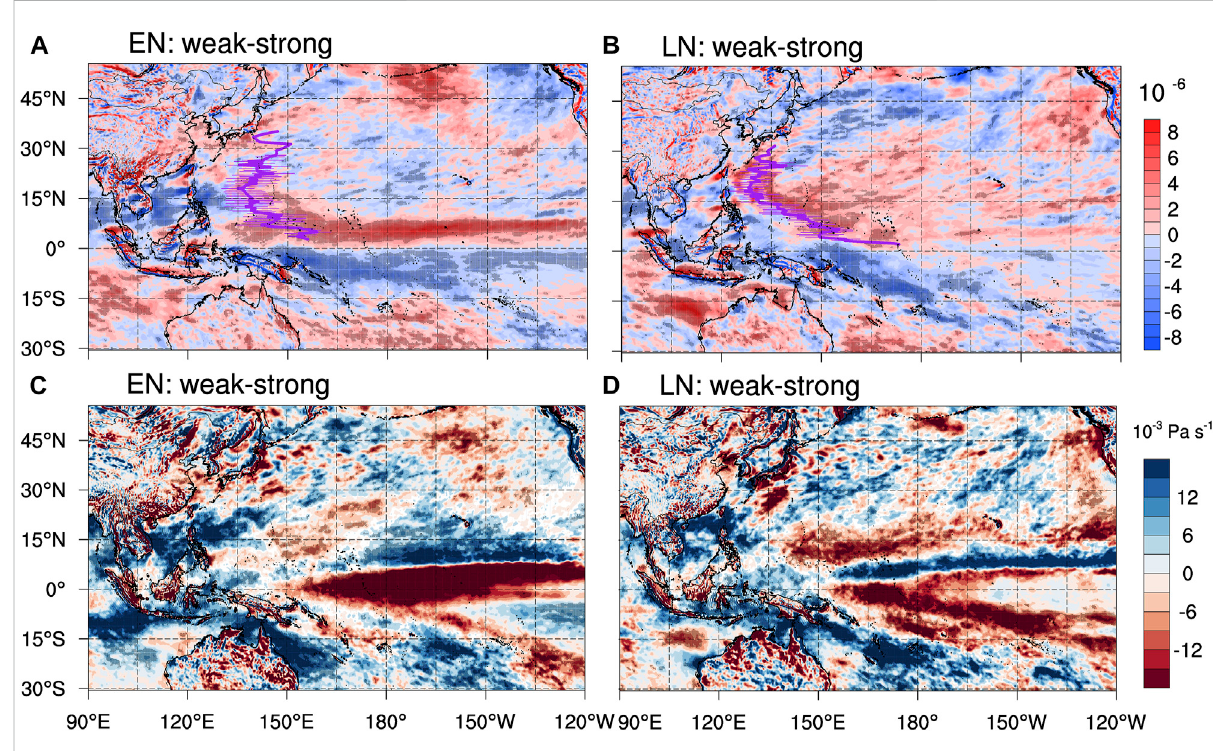
Circulation distributions, averaged during October ‒ December, at the height of 850 hPa. (A) Shading shows the environmental relative vorticity difference between the EN-weak class and the EN-strong class. The thick purple lines show the mean STY path during intensi fi cation for the two classes, and the thin purple lines show ± half of the standard deviation. (C) The vertical velocity difference between the EN-weak class and the EN- strong class (the red hue shows ascending disturbance) (B,D) is the same as that in (A,C) , respectively, but for the LN-weak and LN-strong classes, respectively. Dots indicate areas of > 90% con fi dence level in Student ’ s t